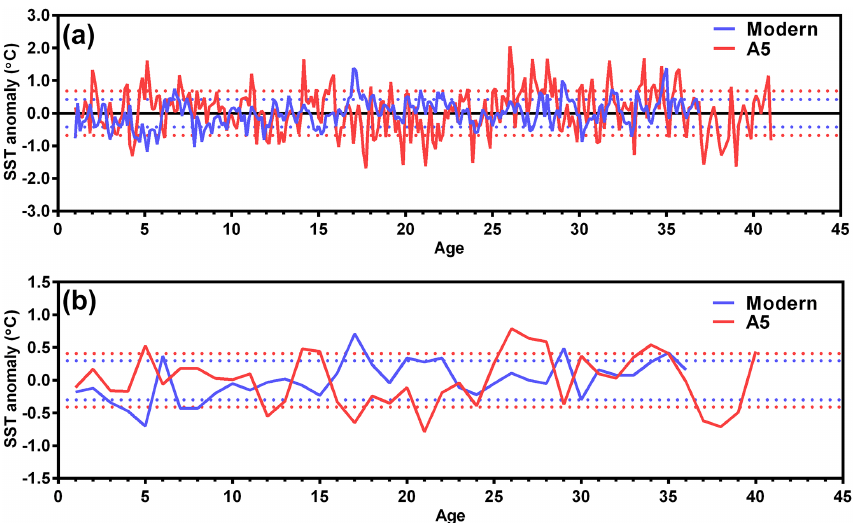
Figure 6. SST anomalies of modern instrumental data and reconstructed SST anomalies of Tridacna A5 under r -monthly (a) and r -annual (b) resolution. Dotted lines represent a standard deviation (1 σ ) of SST